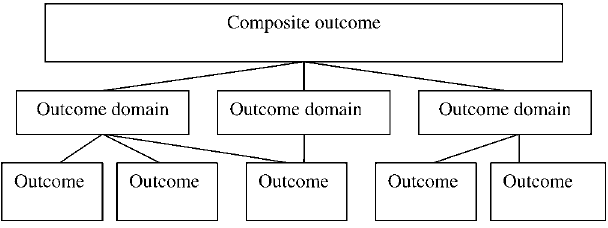
Figure 1. Levels of Outcome